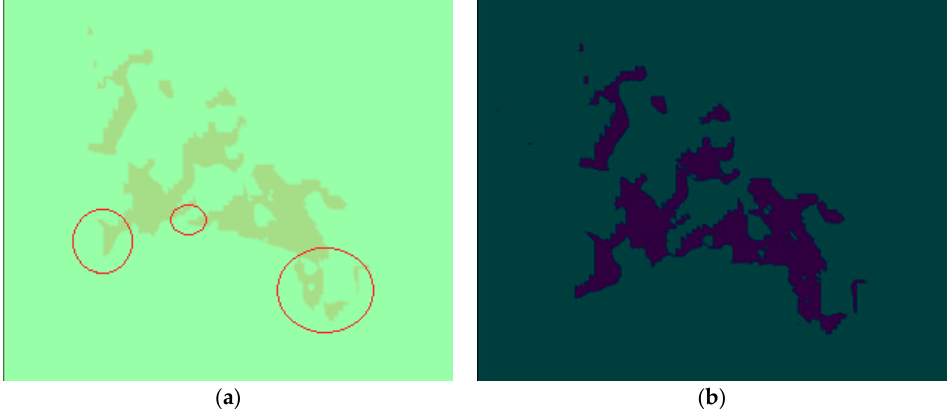
Figure 17. Comparison of results with the data of DEM (30 m resolution): ( a ) visual field range computed using the Matryoshka doll algorithm; and ( b ) viewshed computed using the R3 doll algorithm. The difference in results are enclosed in the red circles in (a).